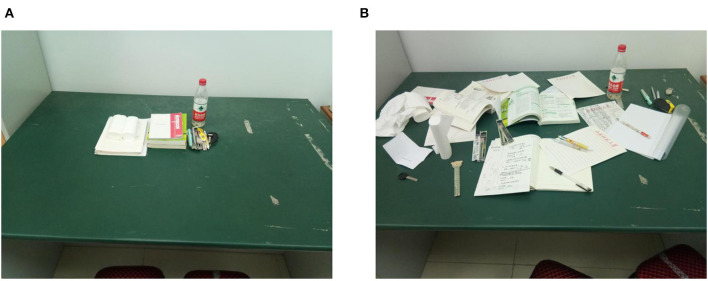
Illustration of the stimuli of Experiment 2: environmental order (A) and disorder (B) pictures.